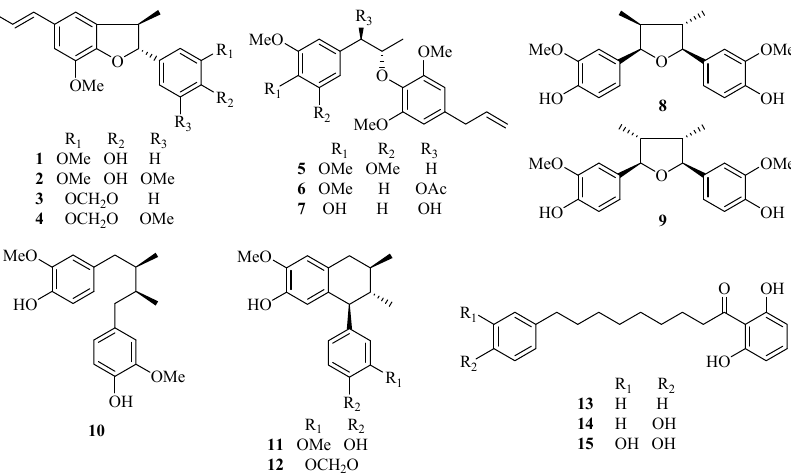
Figure 1. Chemical structures of the fifteen test compounds: dehydrodiisoeugenol ( 1 ), 5-methoxydehydrodiisoeugenol ( 2 ), licarin B ( 3 ), 3 ′ -methoxylicarin B ( 4 ), erythro -2-(4-allyl-2,6- dimethoxyphenoxy)-1-(3,4,5-trimethoxyphenyl)-propane ( 5 ), erythro -2-(4-allyl-2,6-dimethoxyphenoxy)- 1-(3,4-dimethoxyphenyl)propan-1-ol acetate ( 6 ), myrislignan ( 7 ), verrucosin ( 8 ), nectandrin B ( 9 ), dihydroguaiaretic acid ( 10 ), guaiacin ( 11 ), otobaphenol ( 12 ), malabaricone A ( 13 ), malabaricone B ( 14 ), and malabaricone C ( 15 ). Table 1. The bilateral P app values of the 15 test compounds in the MDCK-pHaMDR model and their main physicochemical properties ( n = 3).